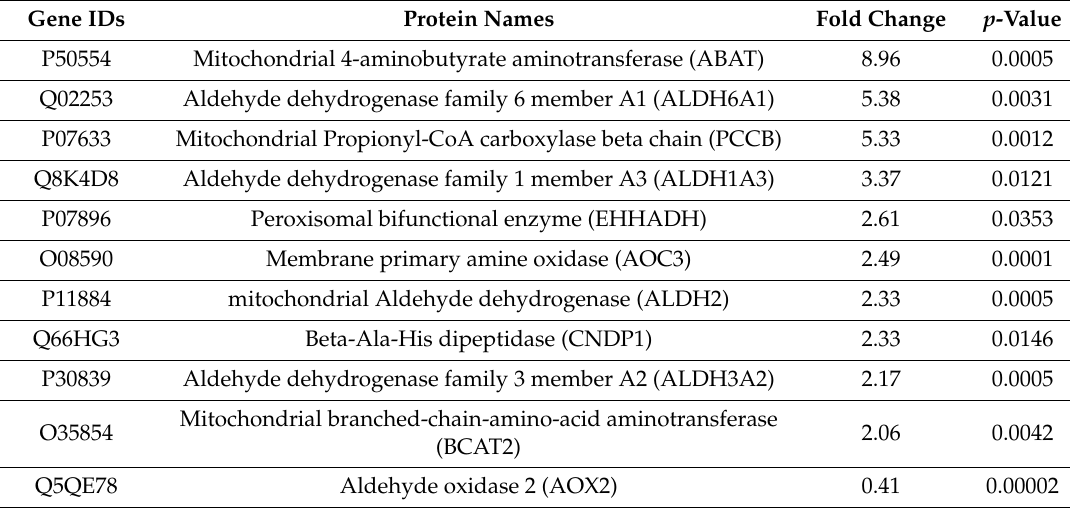
Table 2. DEPs involved in amino acid